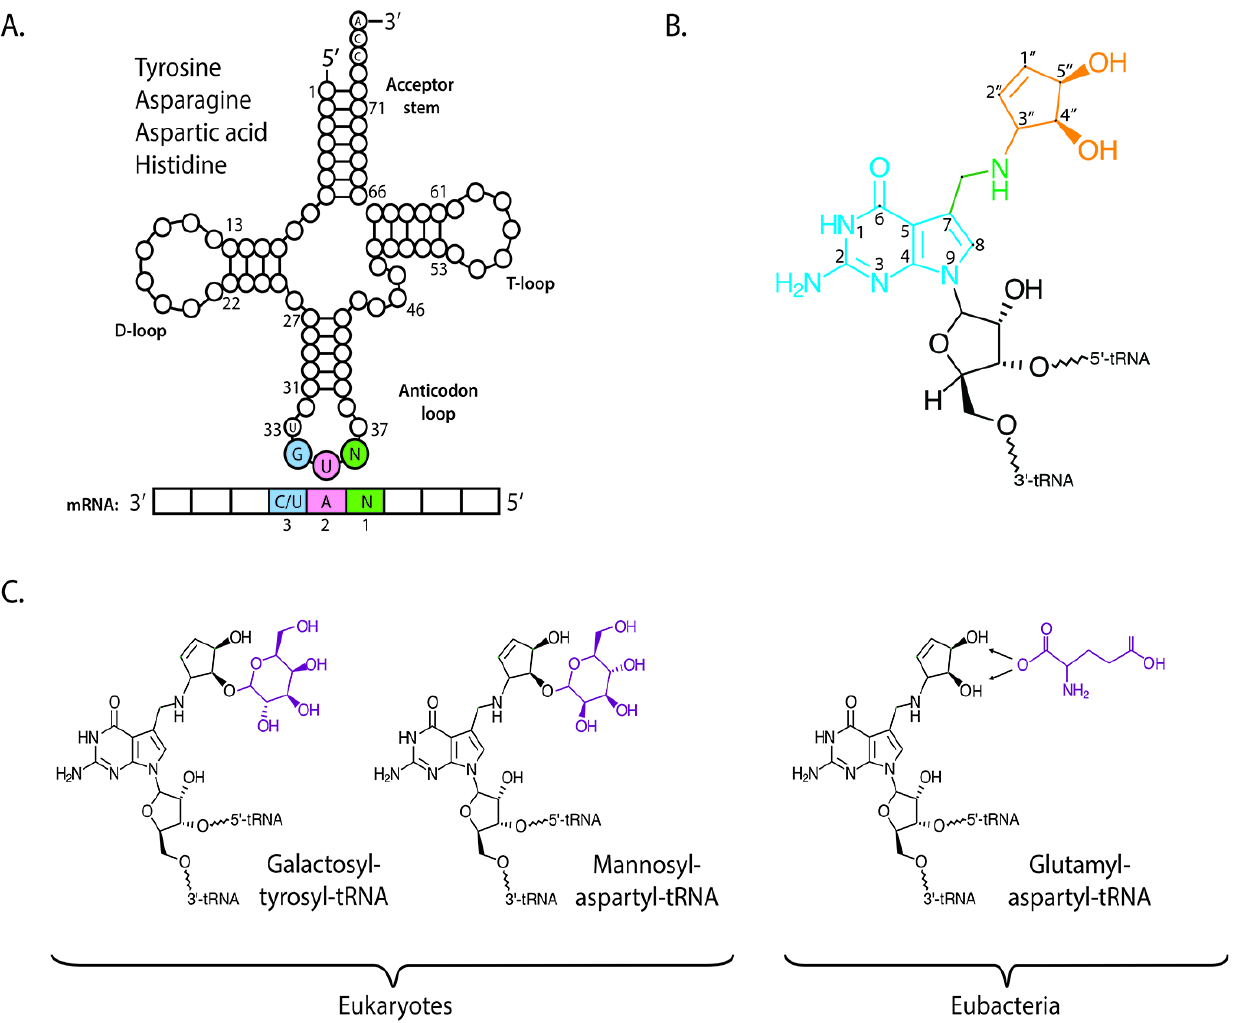
Figure 1. Chemical structure of queuosine and derivatives. ( A ) The G 34 U 35 N 36 anticodon sequence of tRNA isoacceptors for amino acids tyrosine, asparagine, aspartic acid and histidine will base pair with a N 1 A 2 C/U 3 codon of messenger RNA (mRNA). G = guanine, U = uridine, A = adenine, N = any base; ( B ) The International Union of Pure and Applied Chemistry (IUPAC) designation for queuosine: 7-(3,4- trans- 4,5- cis -dihydroxy-1-cyclopenten-3-ylaminomethyl)- 7-deazaguanosine. Classical nucleic acid numbering is shown. The relative stereochemistries of the cyclopentene substituents have been determined as 3,4-trans and 4,5-cis on the basis of NMR comparisons with synthetic models [22]; ( C ) In mammals, the C4″ hydroxyl of the cyclopentanediol ring of queuosine can be modified with galactose in the case of tyrosyl tRNA and mannose in the case of aspartyl tRNA, by yet unknown enzymes. In eubacteria, the C4″ or the C5″ hydroxyl can be modified by the addition of a glutamic acid residue to its non-cognate aspartyl tRNA by a paralog of glutamyl-tRNA synthetase, glutamyl-Q tRNA(Asp) synthetase